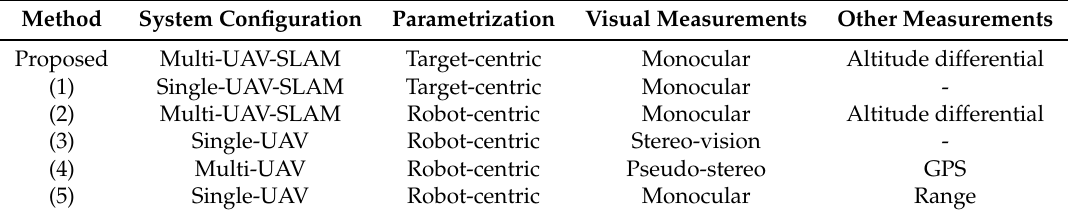
Table 3. Characteristics of the methods used in the comparative study.